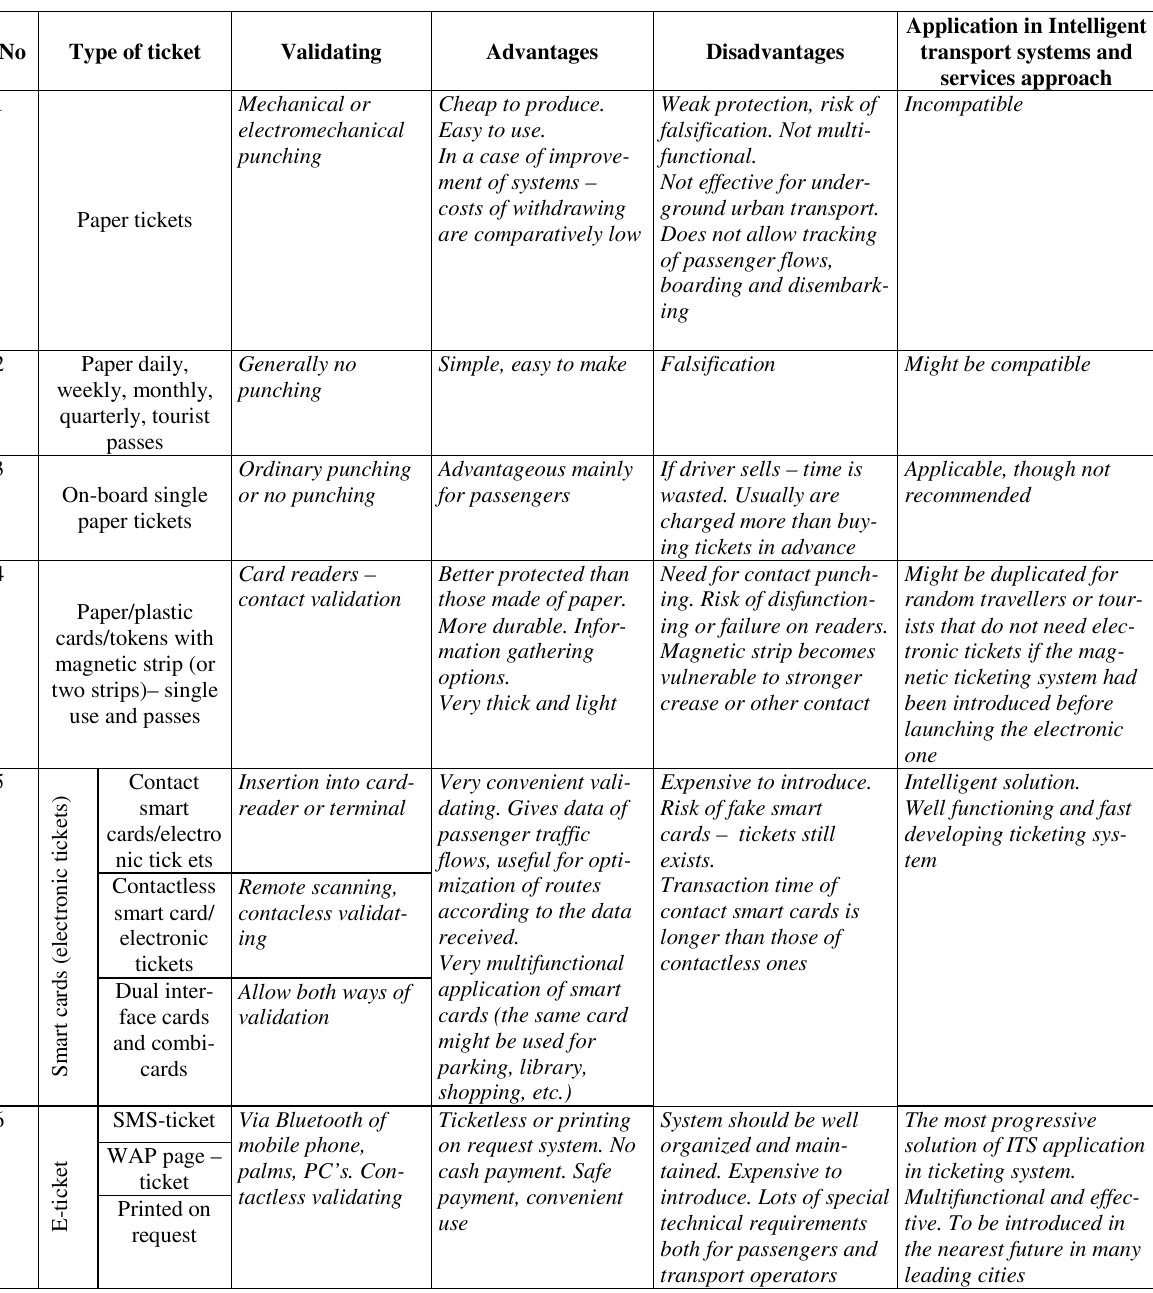
Table 1. Comparison of ticket